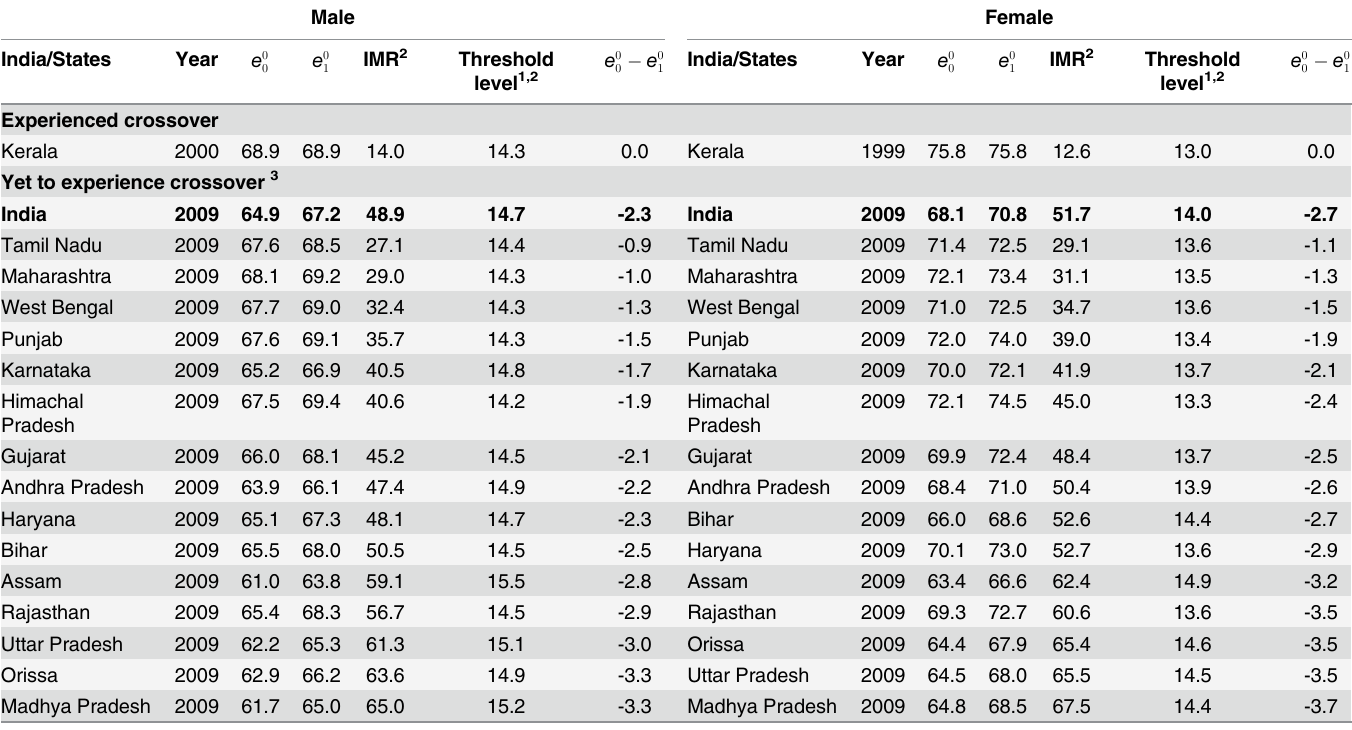
Table 3. Year of crossover, levels of life expectancies at ages zero and one, infant mortality rate and its threshold level by sex, India and